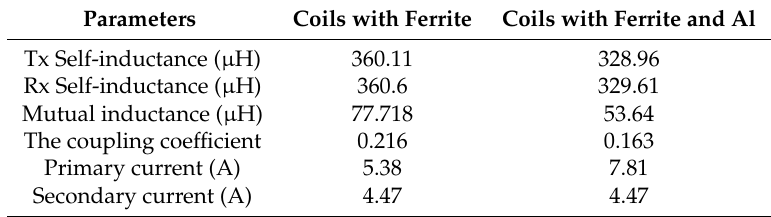
Table 4. The simulation design results for coils with ferrite and coils with core and